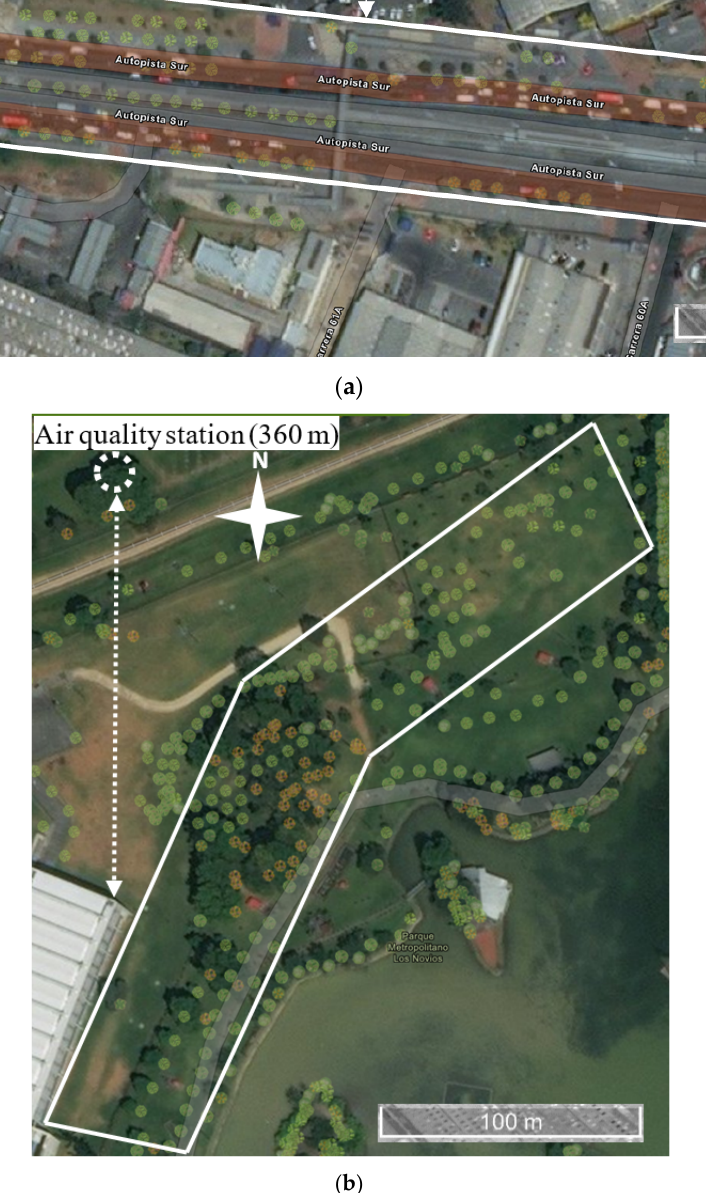
Figure 1. Study sites [24]. ( a ) Zone 1 = South Highway and ( b ) Zone 2 = Simón Bolívar Park.